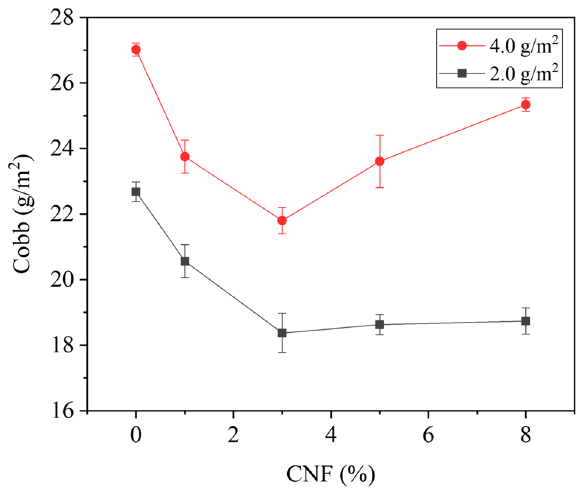
Figure 8. Effect of CNF dosage on hydrophobic properties of paper.